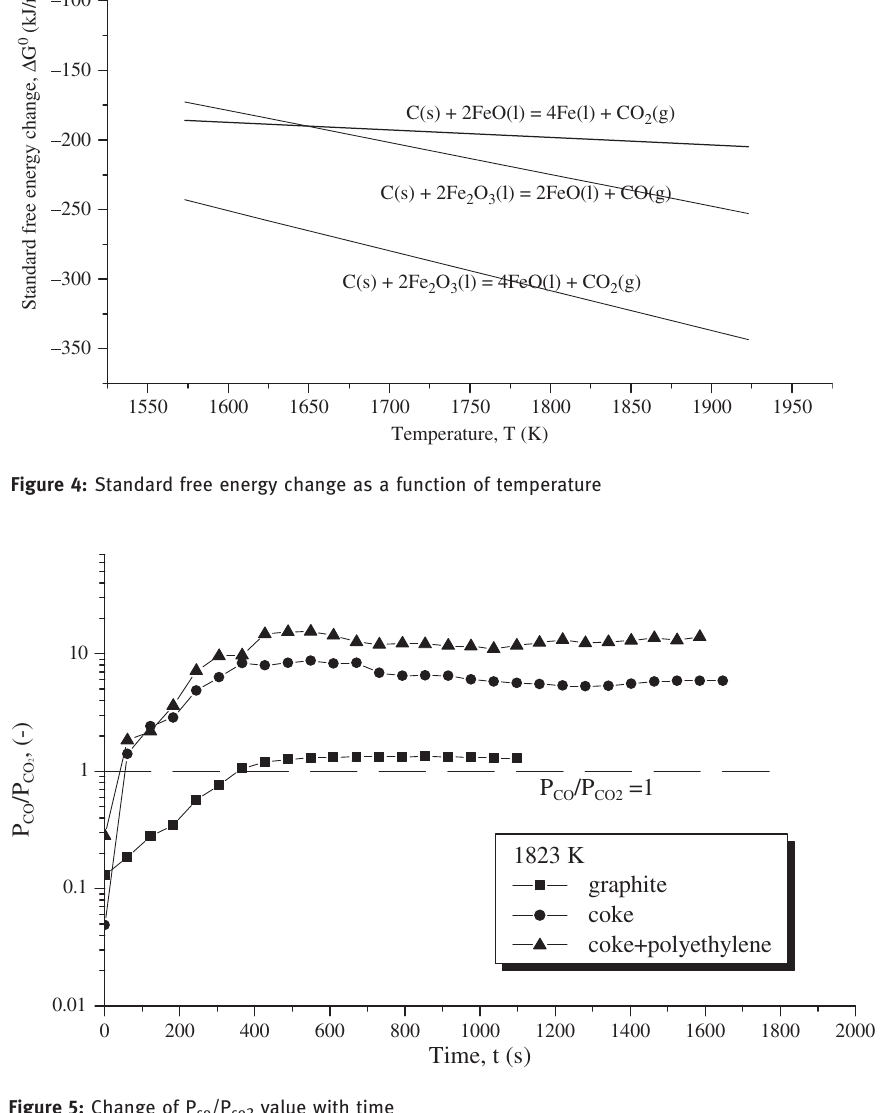
correlation with their respective reaction time in Figure 2 (a) – (c), at which the oxidation reaction transits from the fast reaction rate zone to the slow reaction rate zone of the dominant oxidation product (CO for HDPE þ coke 2 mixture and coke, CO for graphite).